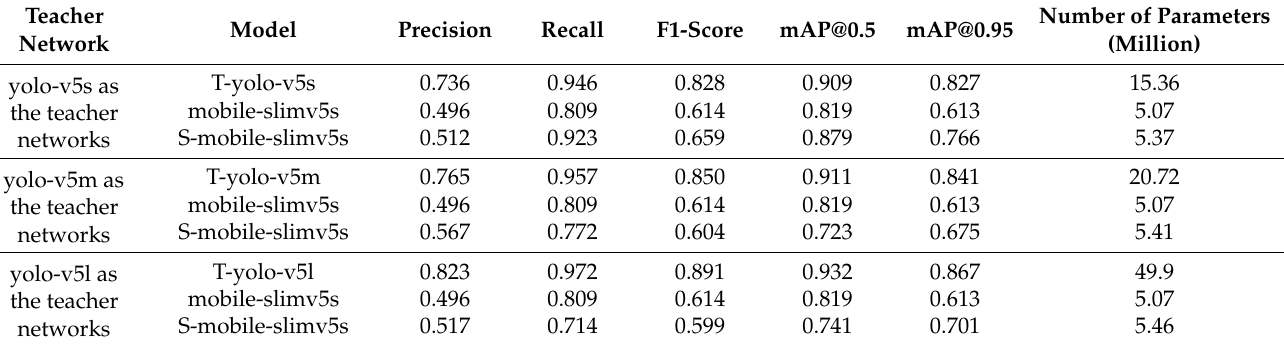
Table 3. Comparison of supervision effects under different teacher